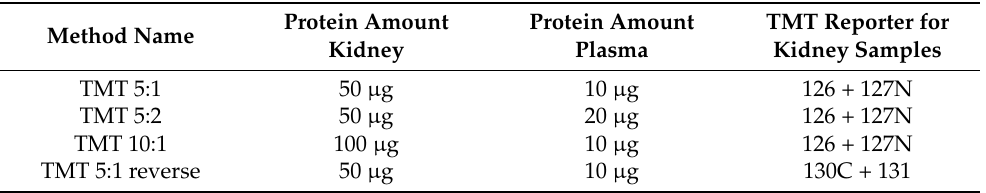
Table 1. Description of the TMT mixtures of kidney and plasma proteins for the various methods tested in this